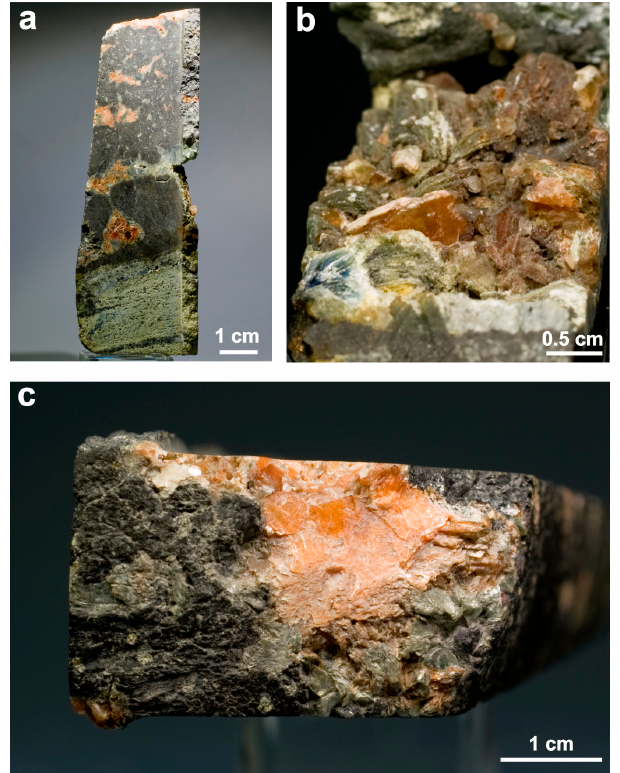
Figure 1. Photos of chlormagaluminite holotype specimen from the collection of Fersman Mineralogical Museum (catalogue number 82771): ( a ) a fragment of drill core consisting of a pyroxene skarn